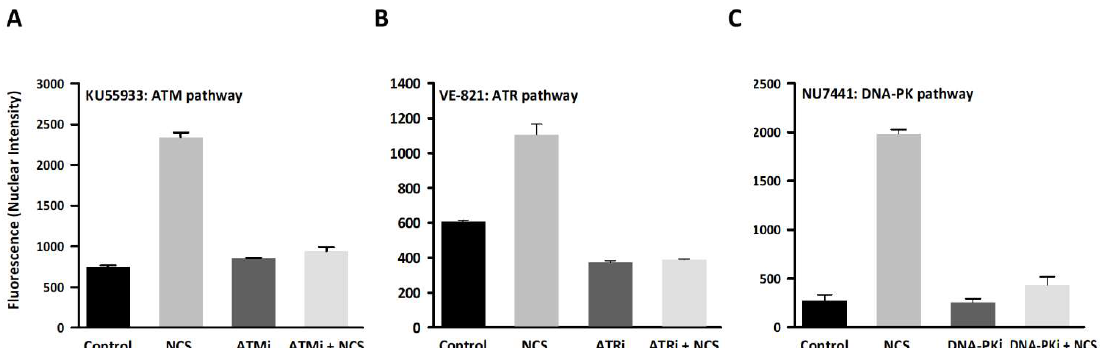
Figure 1. The ability of chemical inhibitors to suppress activation of DNA damage response (DDR) kinases ATM, ATR, and DNA-PK. MRC-5 cells were untreated (Control), treated with the DNA damage inductor NCS, treated with the indicated DDR kinase inhibitor only (ATMi, ATRi or DNA-PKi), or treated with both (neocarzinostatin (NCS) + DDR kinase inhibitor). DDR activation was assayed by fluorescence-based immunocytochemistry using high-content screening to measure fluorescence intensity. The DDR kinase inhibitors used were KU55933 for ATM ( A ), VE-821 for ATR ( B ), and NU7441 for DNA-PK ( C ). Activation of their corresponding targets was determined using antibodies against ATM phosphorylated at Ser1981 ( A ), Chk1 phosphorylated at Ser345 ( B ), or DNA-PK phosphorylated at Ser2056 ( C ). Data are shown as the mean of two independent assays. Fluorescence intensity was measured in 100–300 nuclei foci for each experimental condition. Error bars represent the standard error of the